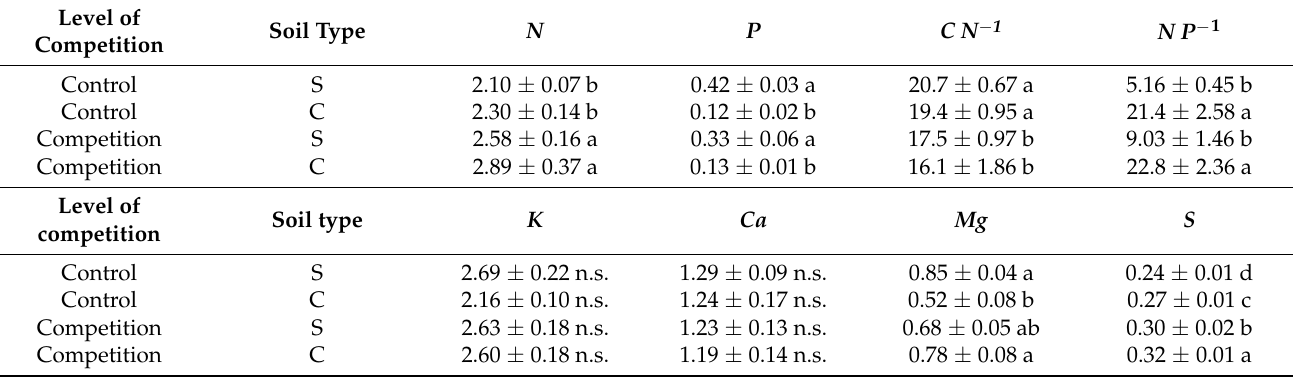
Table 3. Leaf content (%) of macronutrients, C N − 1 and N P − 1 ratios of LANZA ® plants.